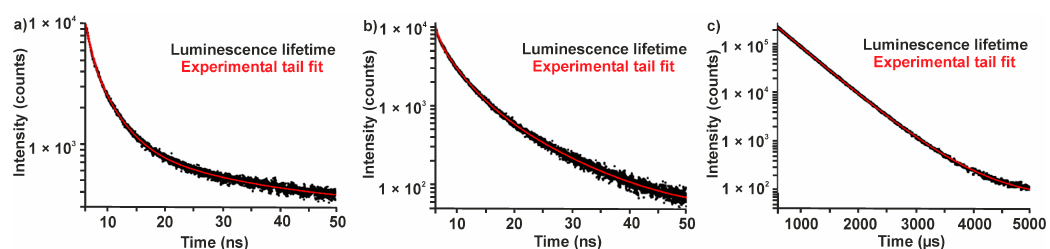
Figure 3. Photoluminescence decay curves Eu-modified C-dots (in PEG400, λ exc = 375 nm): ( a ) as-prepared (Eu 2+ -modified, λ em = 440 nm); ( b ) treatment with dry air (2 months, λ em = 440 nm); and ( c ) treatment with dry air (two months, λ em = 615 nm).